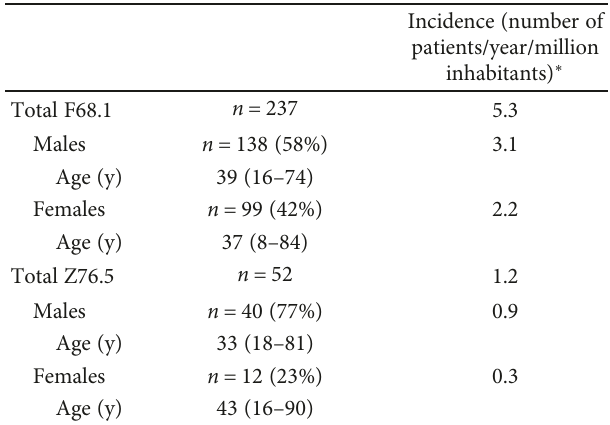
Table 1: Number and age (mean and range) of patients with the diagnosis code F68.1 or Z76.5 in ICD-10 made by Norwegian healthcare providers in the years 2008 to